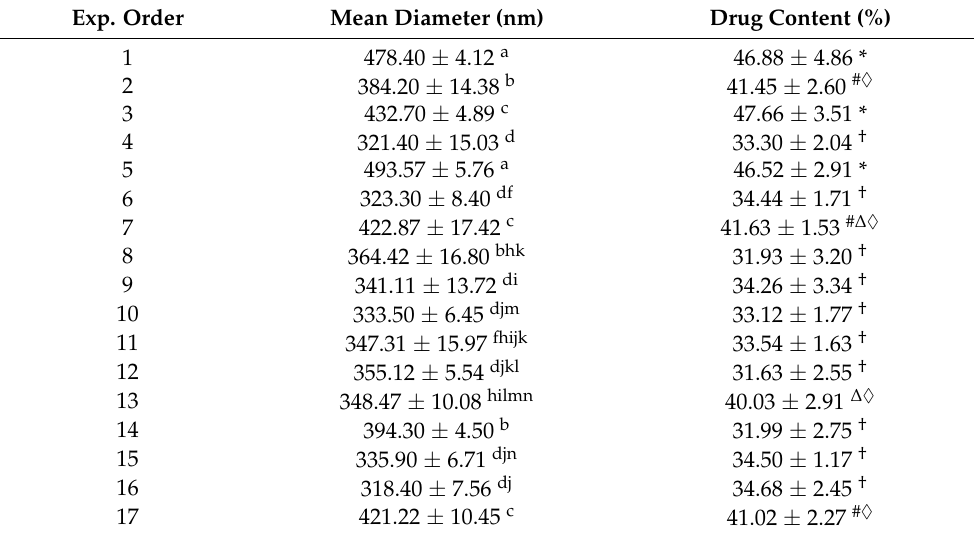
Table 4. Clindamycin loading content in CMCS-Ca 2+ nanoparticles in each experiment. Exp.